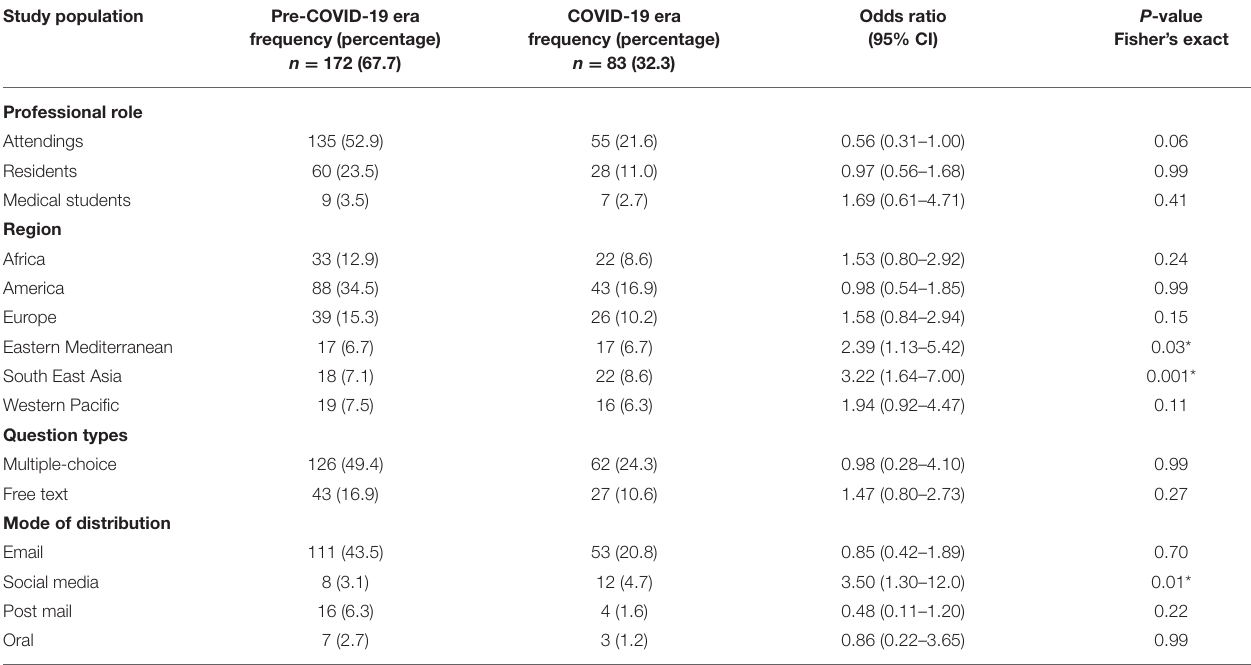
TABLE 1 | Neurosurgery survey study characteristics in the pre-COVID-19 and COVID-19 eras. Study population